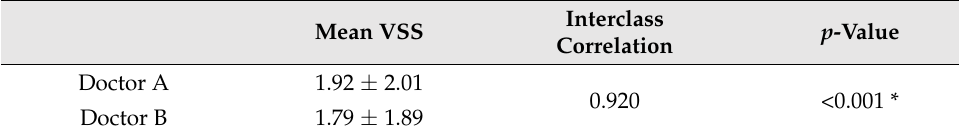
Table 3. Reliability analysis between 2 independent plastic